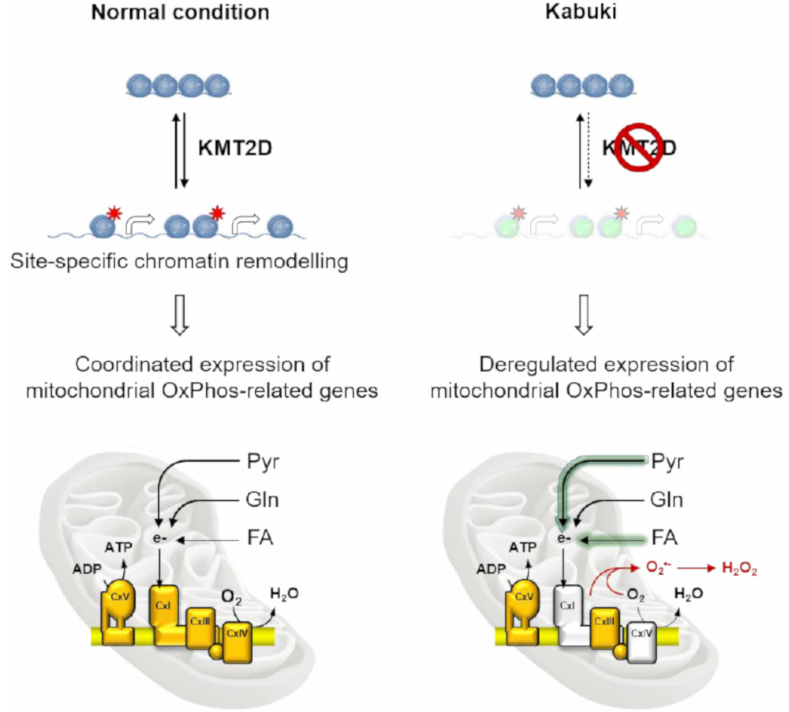
Figure 9. Schematic overview of the e ff ects elicited by KMT2D on the aerobic metabolism as inferred from this study. The normal condition is shown on the left, with KMT2D-mediated chromatin remodeling controlling the coordinated expression of mitochondrial OxPhos-related genes. Alterations in the KMT2D-null context as in the Kabuki syndrome are shown on the right. Impairments include decreased expression and activity of the respiratory chain complexes I and IV with reduced oxygen consumption and the generation of reactive oxygen species. Altered flexibility in the oxidative utilization of pyruvate (Pyr) and long-chain fatty acids (FAs) is also shown as shadowed arrows; Gln, glutamine. See the discussion for further